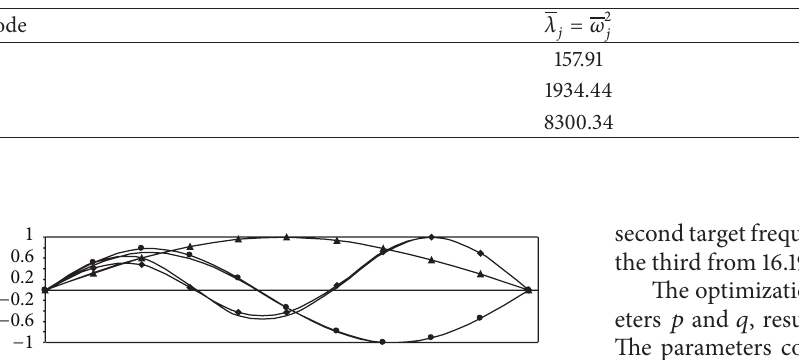
Figure 5: Optimal and target mode shapes (Case